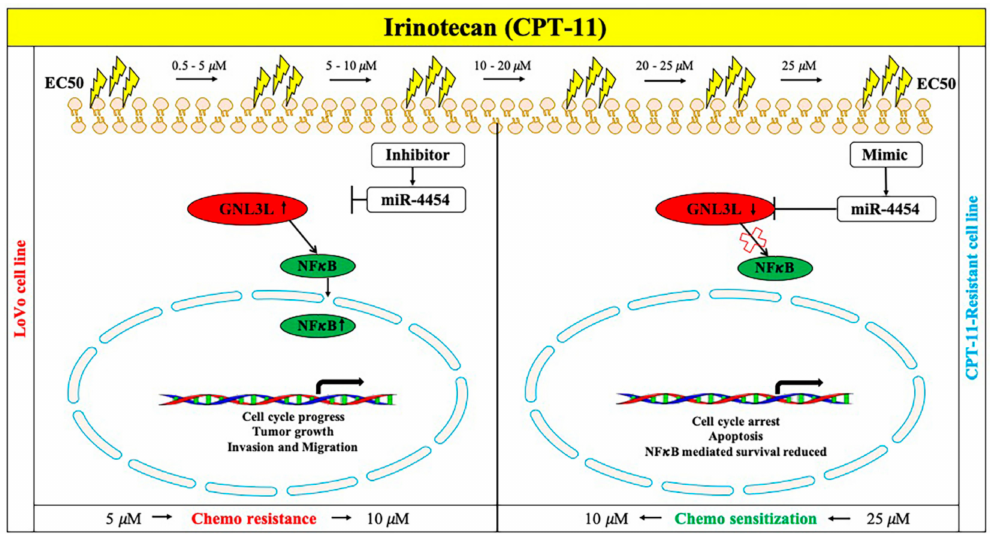
Figure 9. Schematic representation of the miR-4454 / GNL3L / NF κ B